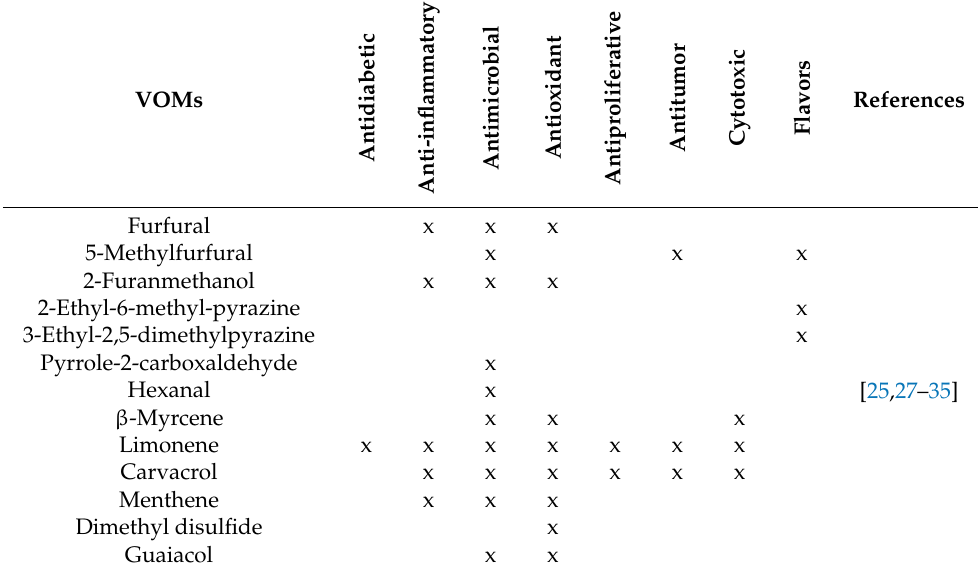
Table 2. Potential properties of some important volatile organic metabolites (VOMs) identified in spent coffee grounds SCGs analyzed in this study.